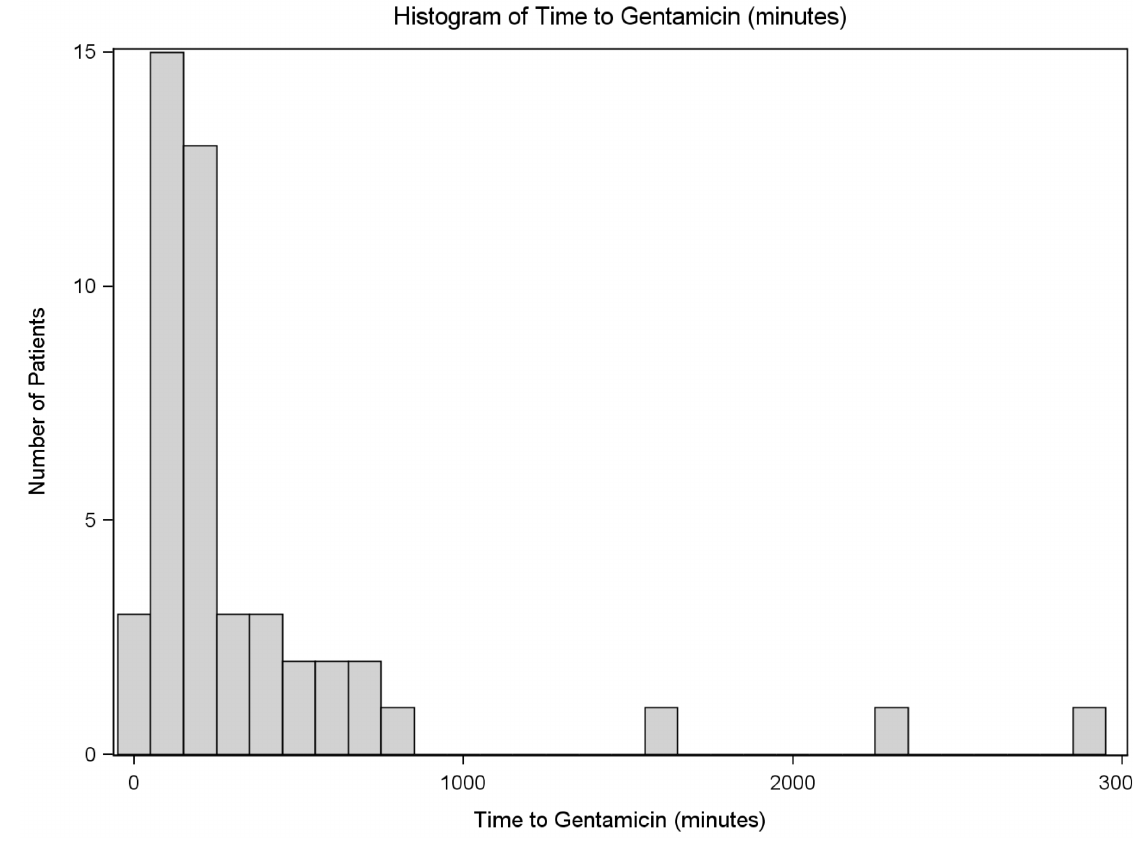
Fig 2. Timing of gentamicin for all patients. Demonstration of the distribution of all patients and their associated time to gentamicin administration. Patients are not classified based on open fracture type or triaging group.